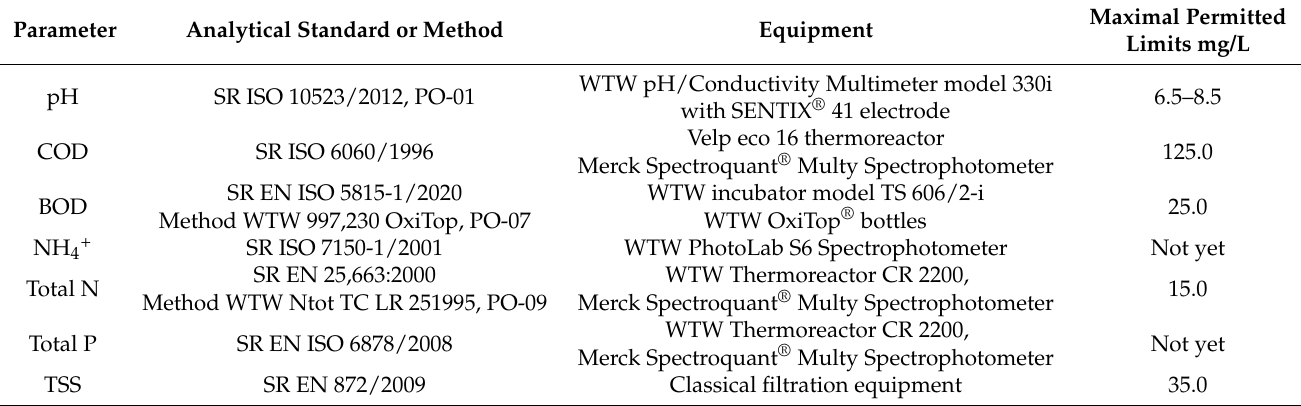
Table 3. Parameters and their analytical methods used in the Agnita